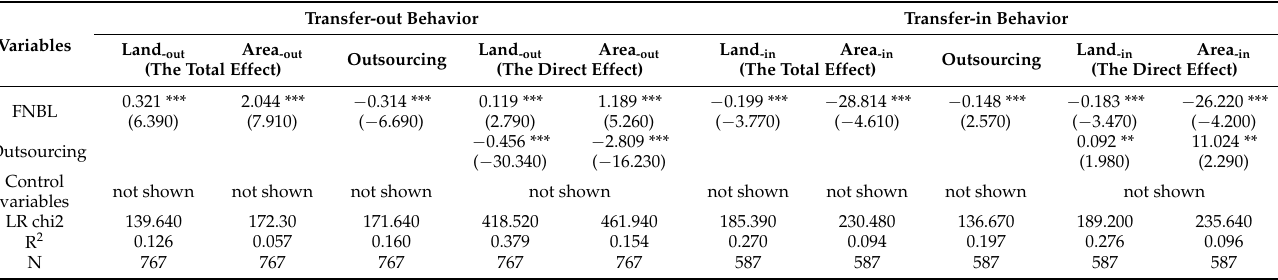
Table 5. Results of robustness